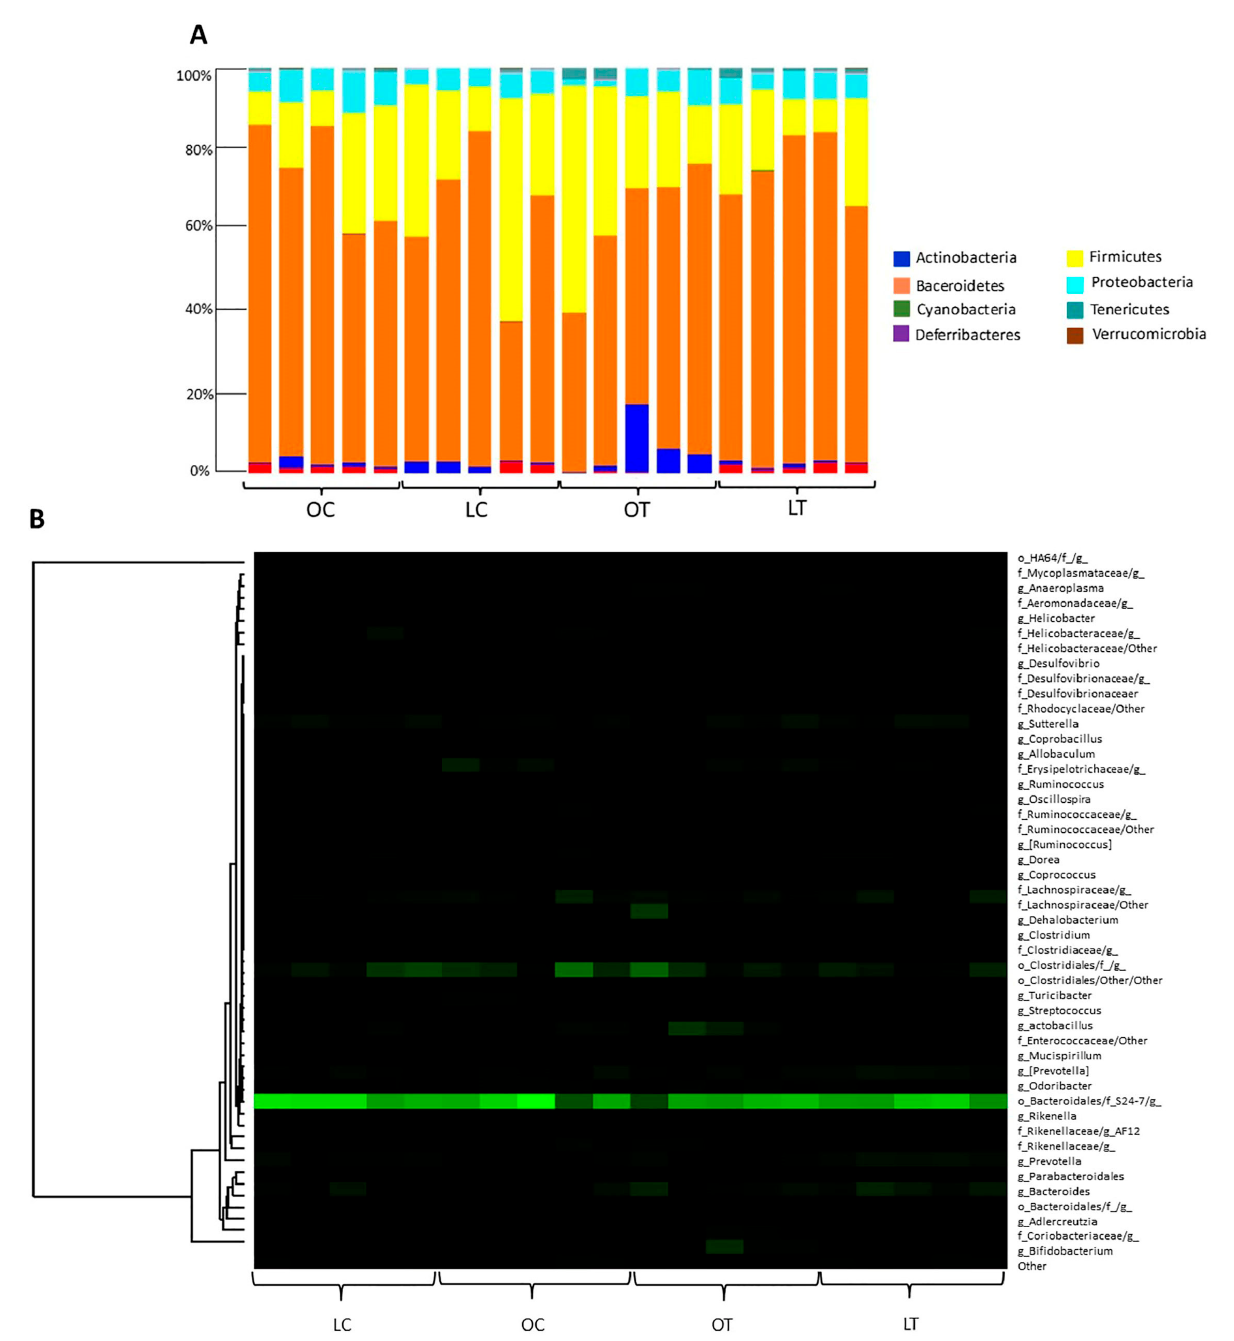
Figure 5. The relative abundance of bacteria under different sample storage conditions is represented by operational taxonomic units (OTUs) according to phyla ( A ). Heatmap of relative abundance at the genus level ( B ). Legend: OC, obese control group; LC, lean control group; OT, obese treated group; LT, lean treated group.